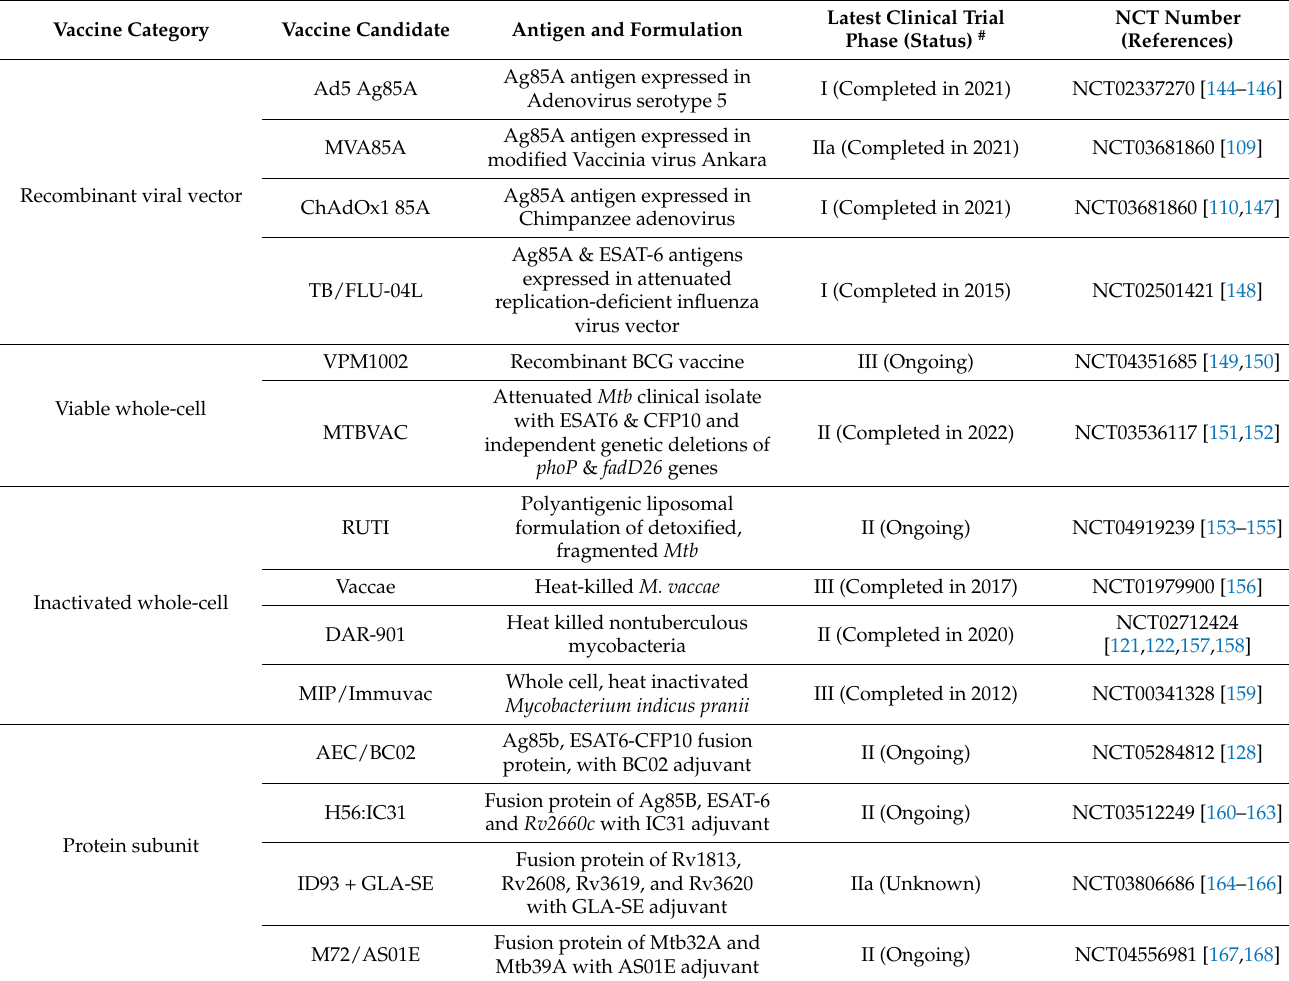
Table 2. TB vaccine candidates with clinical trial